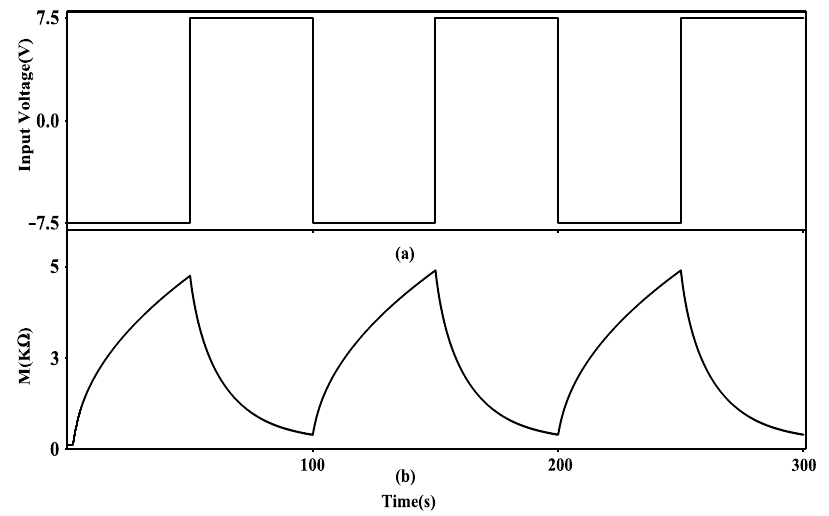
Figure 2. The memristance variation of the modeled memristor. ( a ) Input signal and ( b ) the memristance response. Table 1. The key parameters of the modeled memristor.